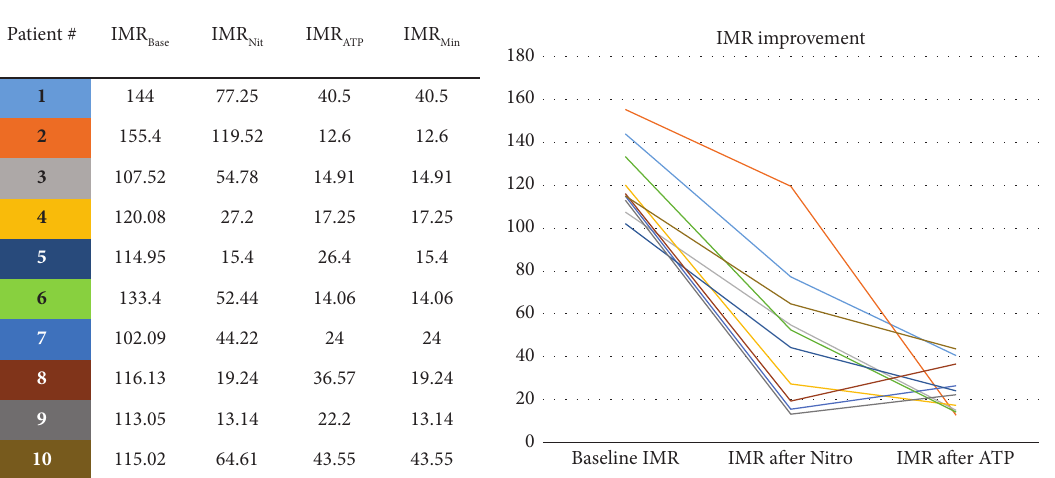
Figure 2:10 cases underwent IMR examination. The baseline IMR (IMR Base ) was distributed between 100 and 160, and 3 patients had higher IMR induced by ATP (IMR ATP ) than IMR induced by nitroglycerin (IMR Nit ), suggesting difference in the position of functional mi- crocirculatory